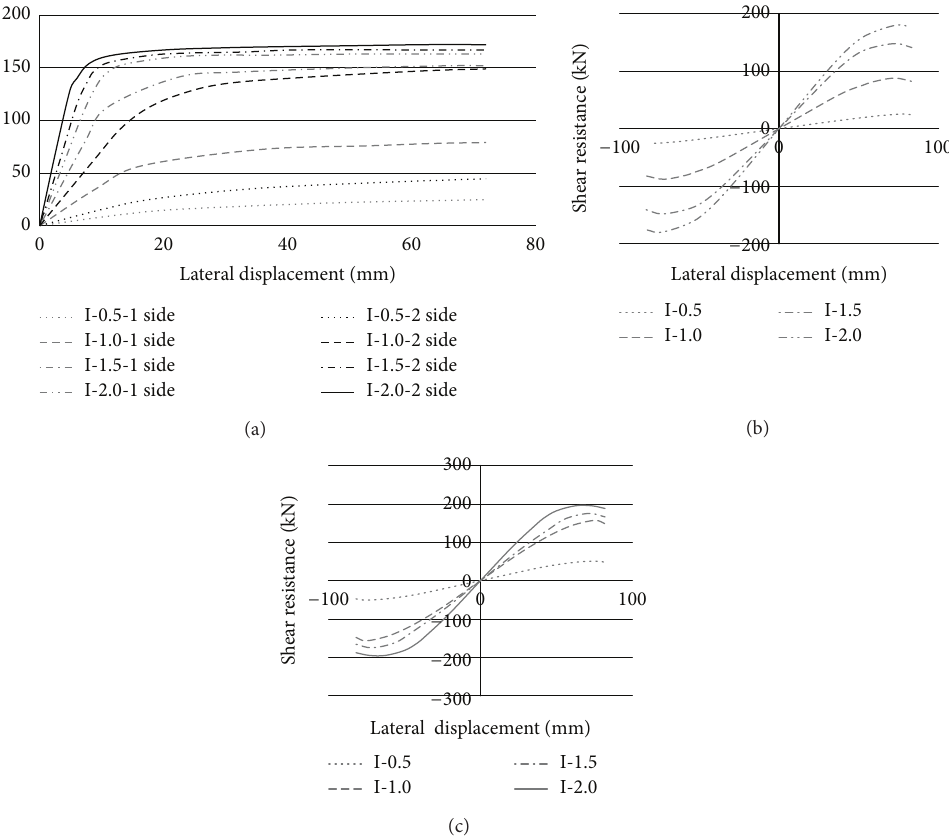
Figure 11: Curves for specimens I. (a) Monotonic curves. (b) Hysteretic envelope curves 1-side. (c) Hysteretic envelope curves 2-side.